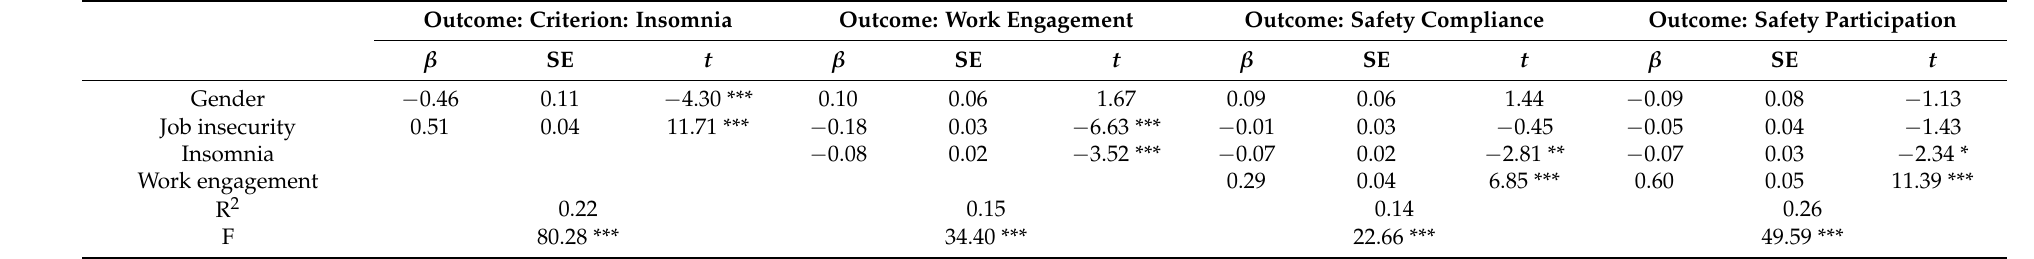
Table 3. The mediating role of insomnia and work